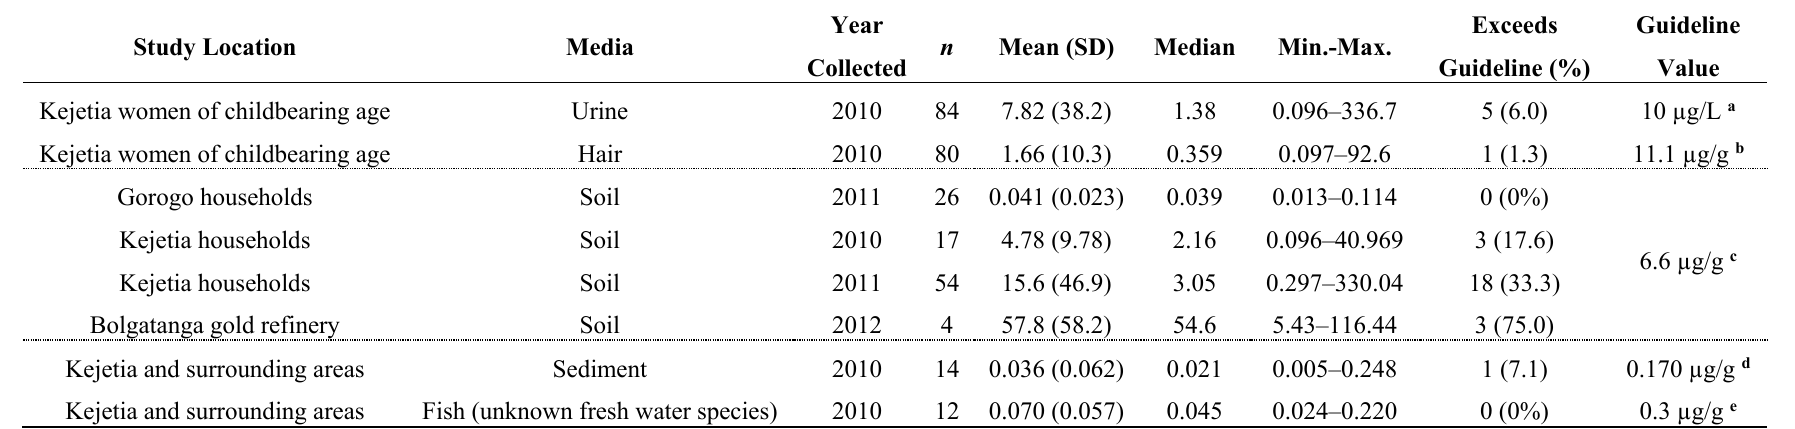
Table 3. Total mercury (Hg) concentrations (µg/g d.w.) in urine (µg/L), hair, soil, sediment, and fish samples collected 2010–2012 in Gorogo, Kejetia, and Bolgatanga, Upper East